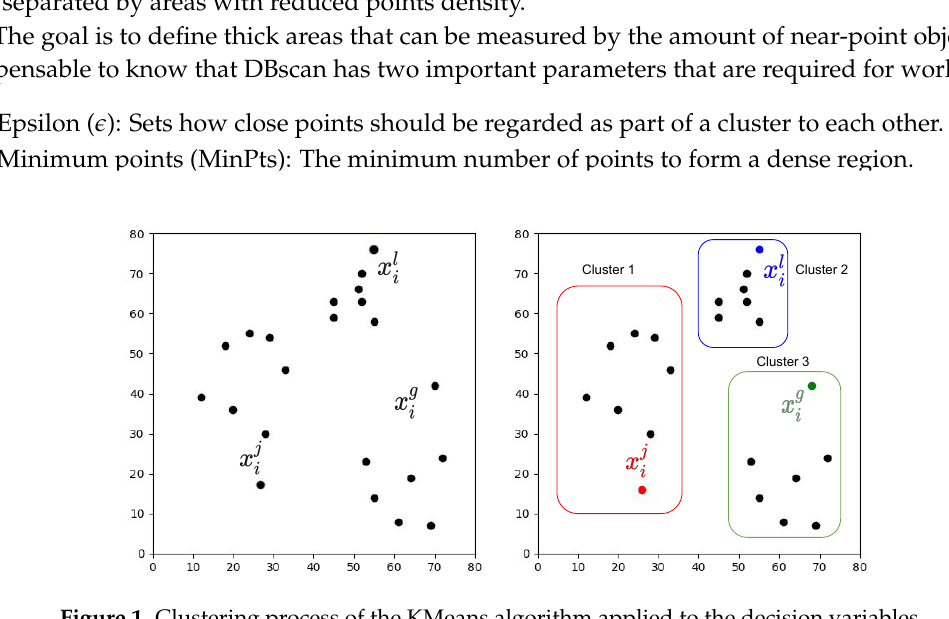
Figure 1. Clustering process of the KMeans algorithm applied to the decision variables.